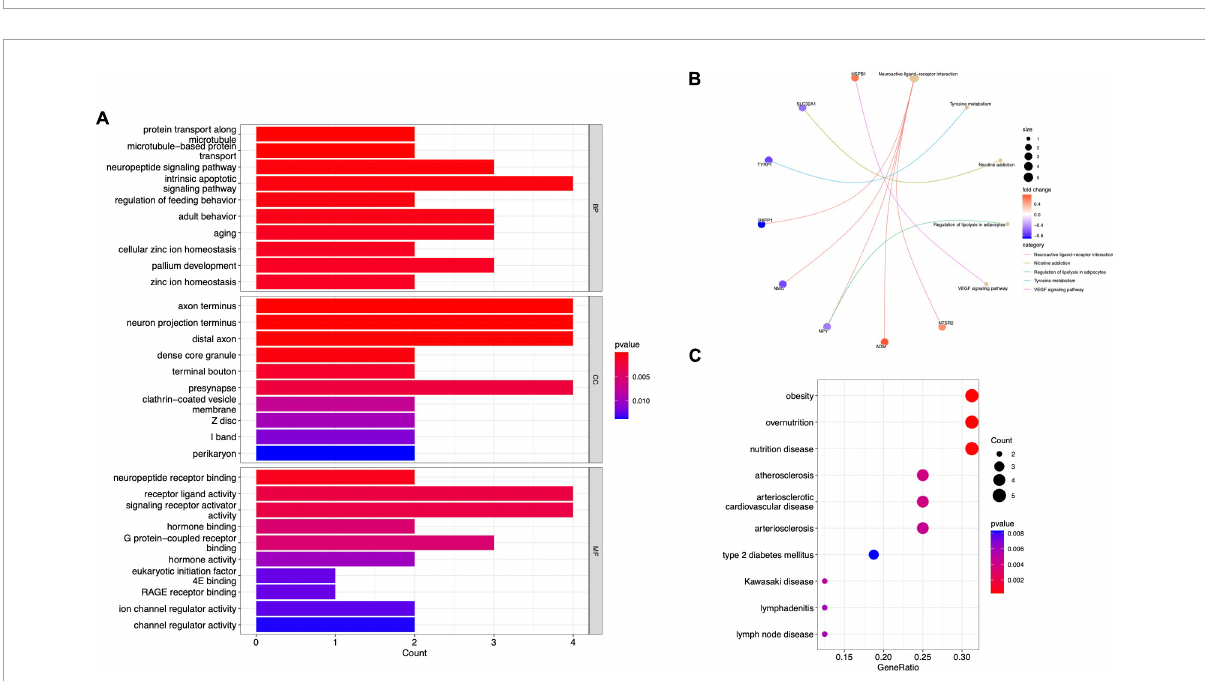
FIGURE3 Functional DEG enrichment. (A) GO analysis. (B) KEGG pathway analysis. (C) DO